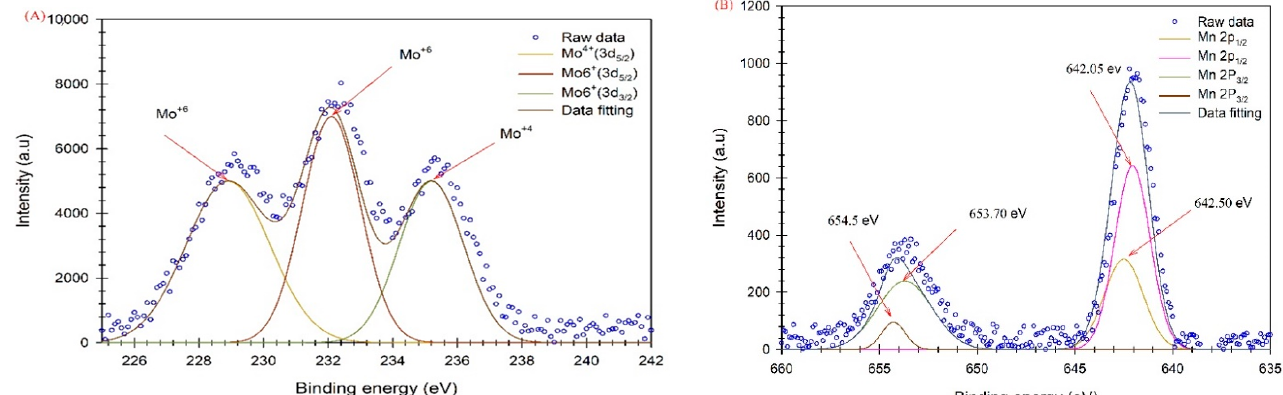
Figure 4. X-ray photoelectron spectroscopy (XPS) analysis of Mn (0.5%) -Mo (0.1%) /AC. ( A ) Molybdenum (Mo) oxidation statuses and ( B ) Manganese (Mn) oxidation statuses. num (Mo) oxidation statuses and ( B ) Manganese (Mn) oxidation